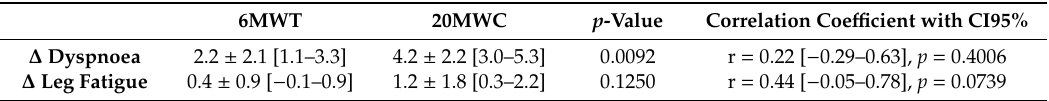
Table 3. Perceived di ff erences in dyspnoea and leg fatigue measured at the beginning and end of each after the test − Leg Fatigue before the